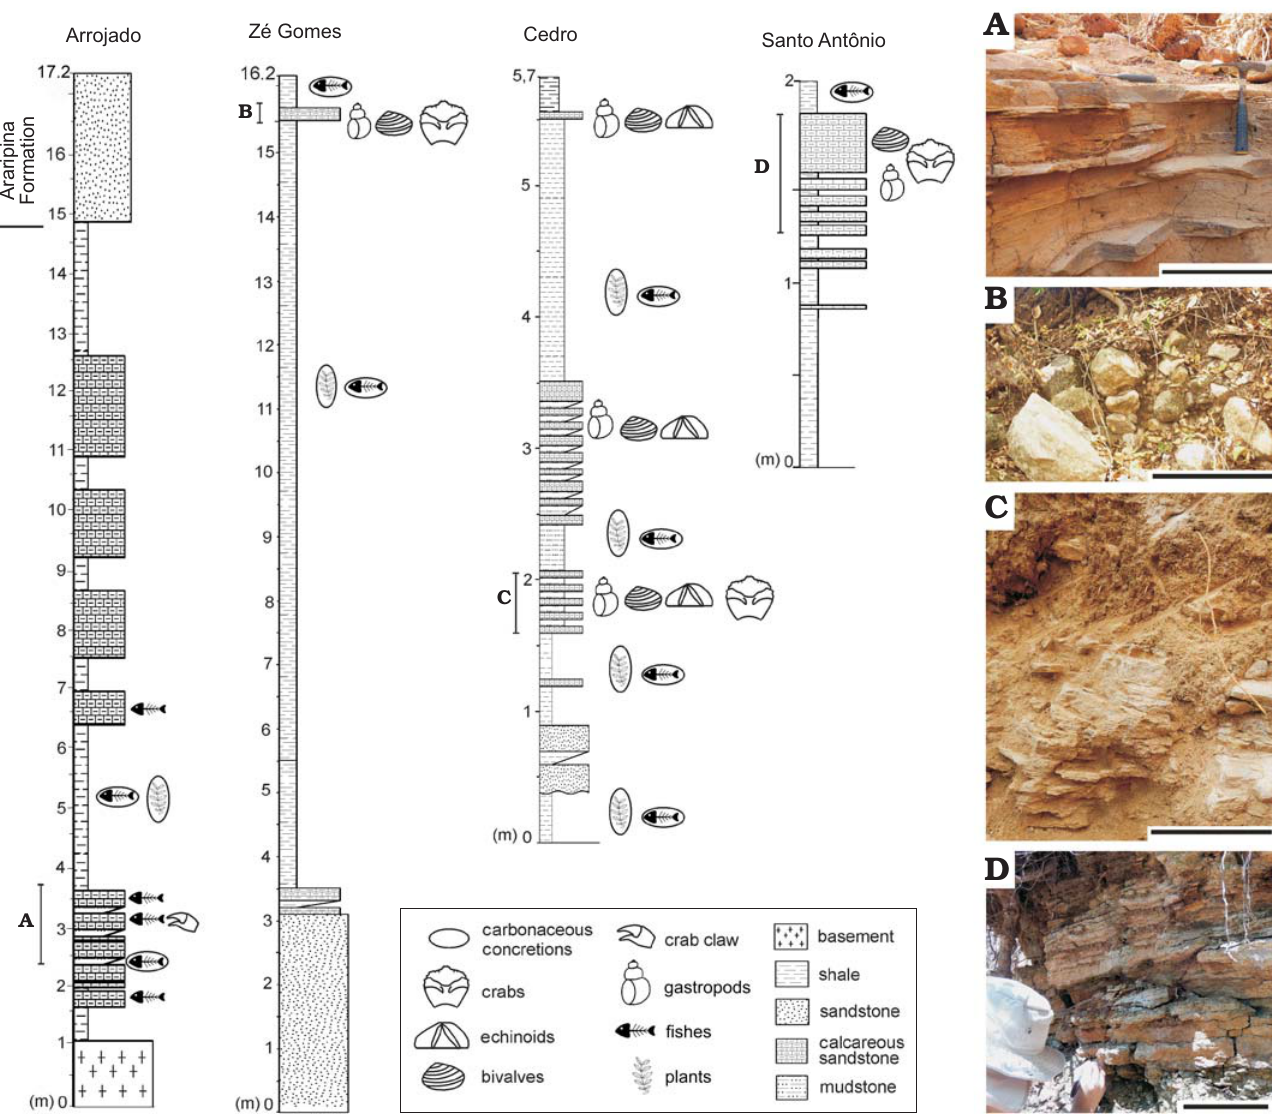
Fig. 2. Stratigraphic sections (A 1 –D 1 ) and field photographs (A 2 –D 2 ) of the upper Lower Cretaceous Romualdo Formation, Pernambuco, Brazil, where the new brachyuran crabs were discovered: Arrojado site ( A ), municipality of Araripina, Zé Gomes ( B ), Cedro ( C ), and Santo Antônio ( D ) sites, municipality of Exu. Scale bars 25